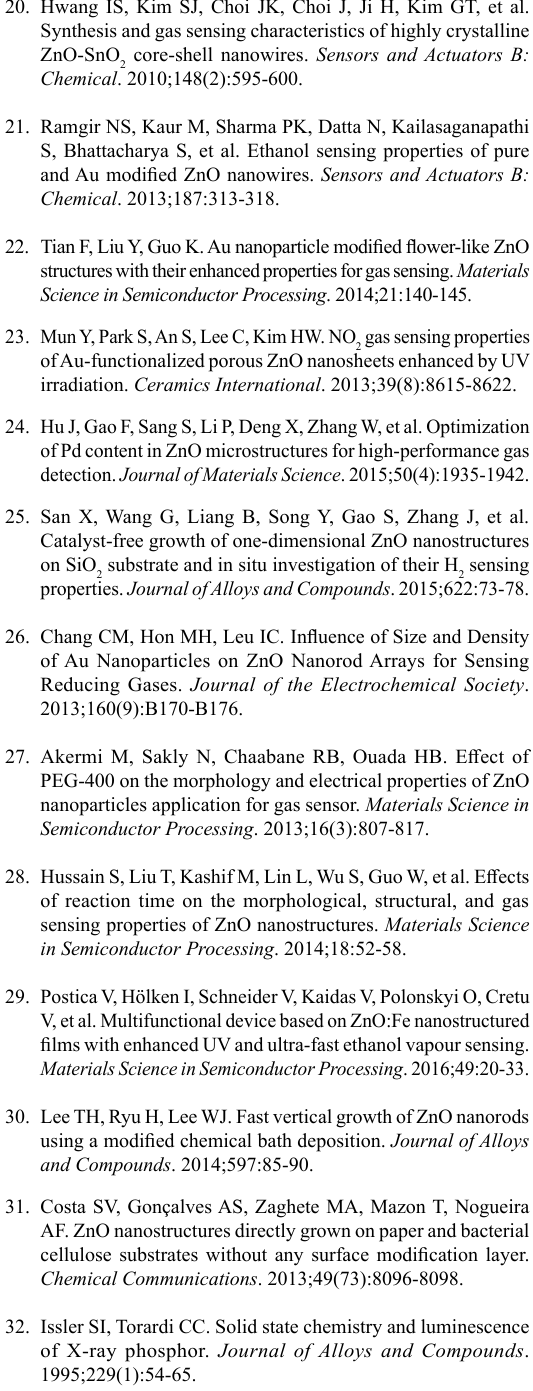
Figure S1 - SEM images of the ZnO NRs- Au NPs hybrids supported on substrates heat treated at